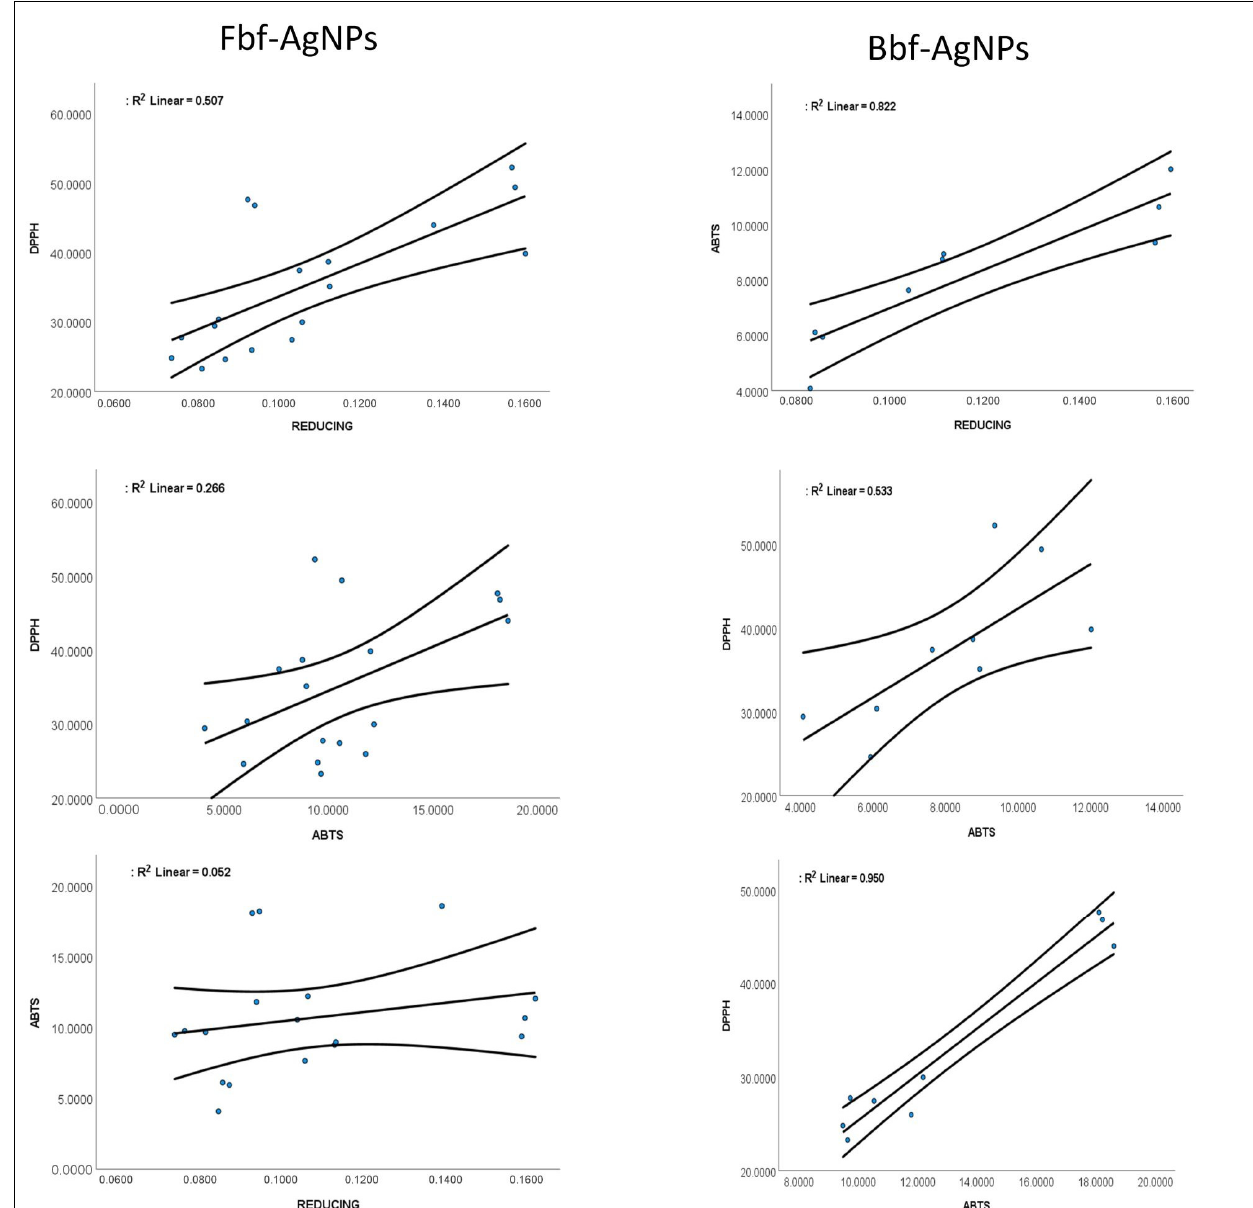
Figure 9. Correlation curves between the different antioxidant parameters (reducing power, ABTS and DPPH assay) of Fbf-AgNPs and